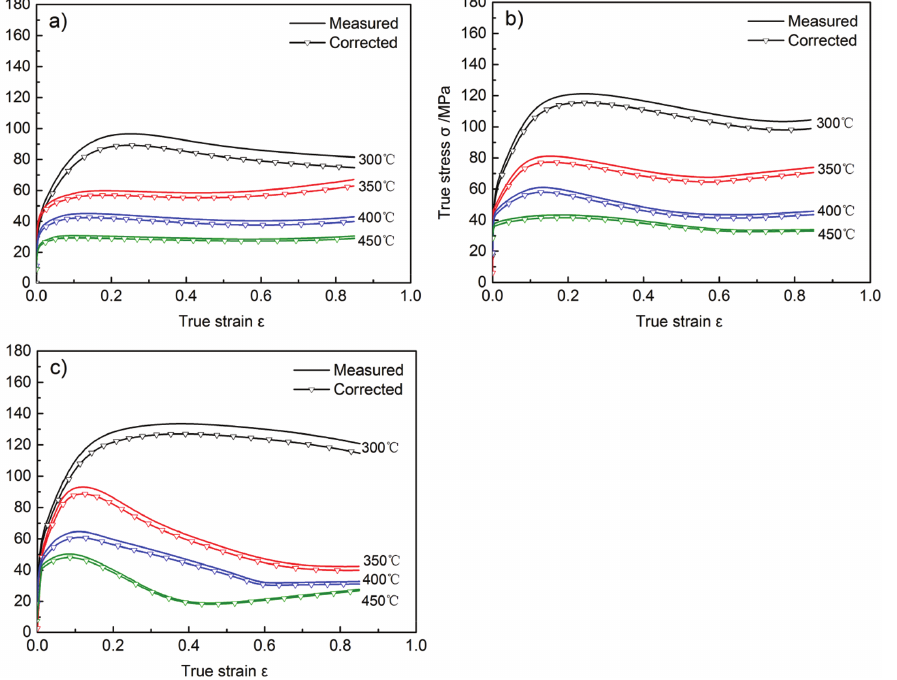
Figure 2: Flow curves of the AZ31 magnesium alloy under different deformation temperatures with strain rates of (a) 0.01s – 1 , (b) 0.1s − 1 , and (c) 1s − 1 .